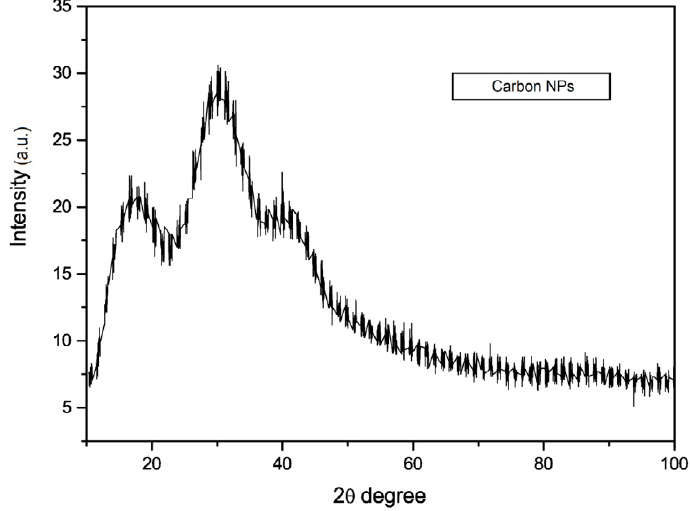
Fig. 4. XRD Pattern of Carbon